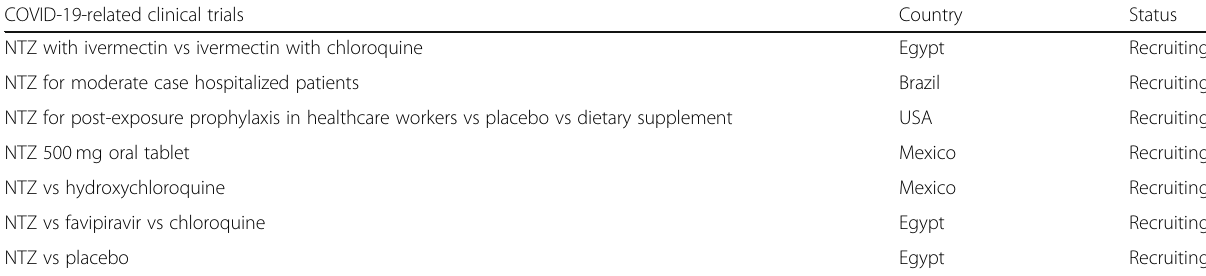
Table 2 Current clinical trials to assess NTZ for treatment of COVID-19 COVID-19-related clinical